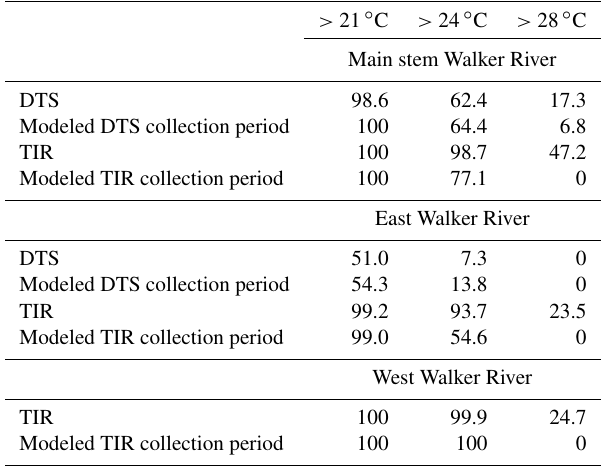
Table 5. Percentage of DTS, TIR, and RMS model stream temper- atures that exceed 21, 24, and 28 ◦ C temperature